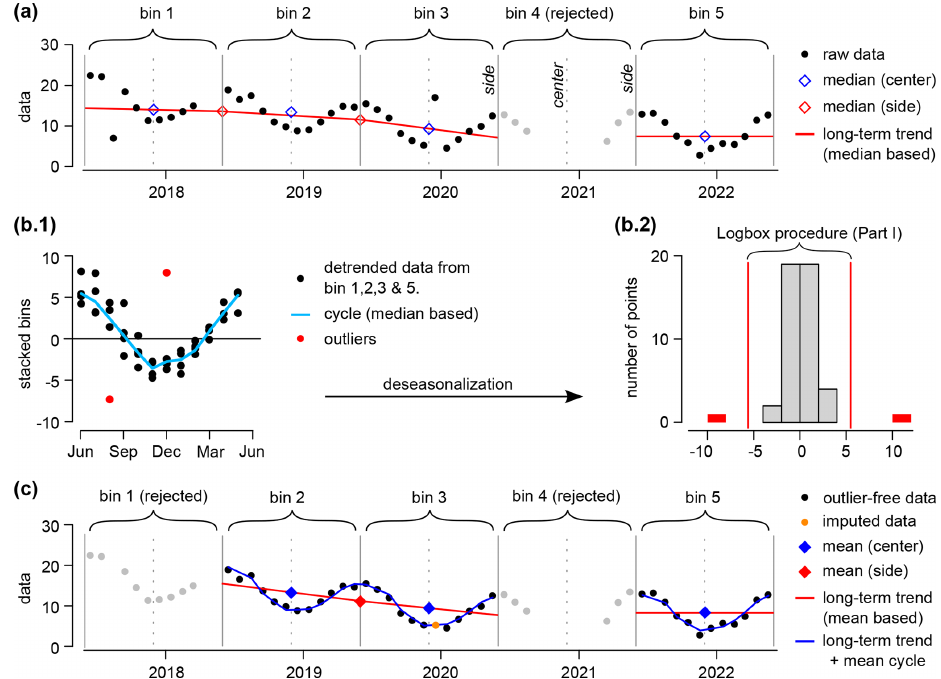
Figure 3. Example of the aggregation procedure with the following inputs: bin side = 1 June 2020, bin period = 1 year, f NA = 0 . 2 (minimum of 10 months of data for a bin to be accepted), and SCI min = 0 . 6 (cyclic imputation level). The bin 4 has been rejected because it contains only 6 months of data (a) . Two outliers have been flagged in the residuals (detrended and deseasonalized data, b.2 ). After the outliers have been replaced with NA values, the bin 1 has been rejected (9 months of data), and the long-term trend and cycle have been updated using the mean instead of the median (c) . A point in bin 3 has been imputed based on the cyclicity (SCI min ≤ SCI = 0 . 61).